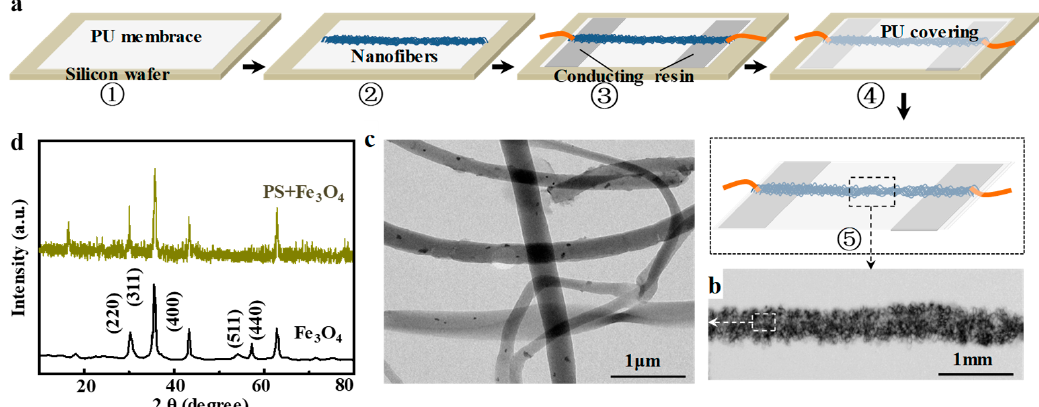
Figure 11. ( a ) Schematic depiction of the fabricating process of strain sensor with nanofiber strips. ( b ) Optical image of fibrous strips from magnetic spinning. ( c ) TEM image of PS@Fe3O4 nanofibers. ( d ) XRD patterns of PS and PS- Fe3O4 composite nanofibers.